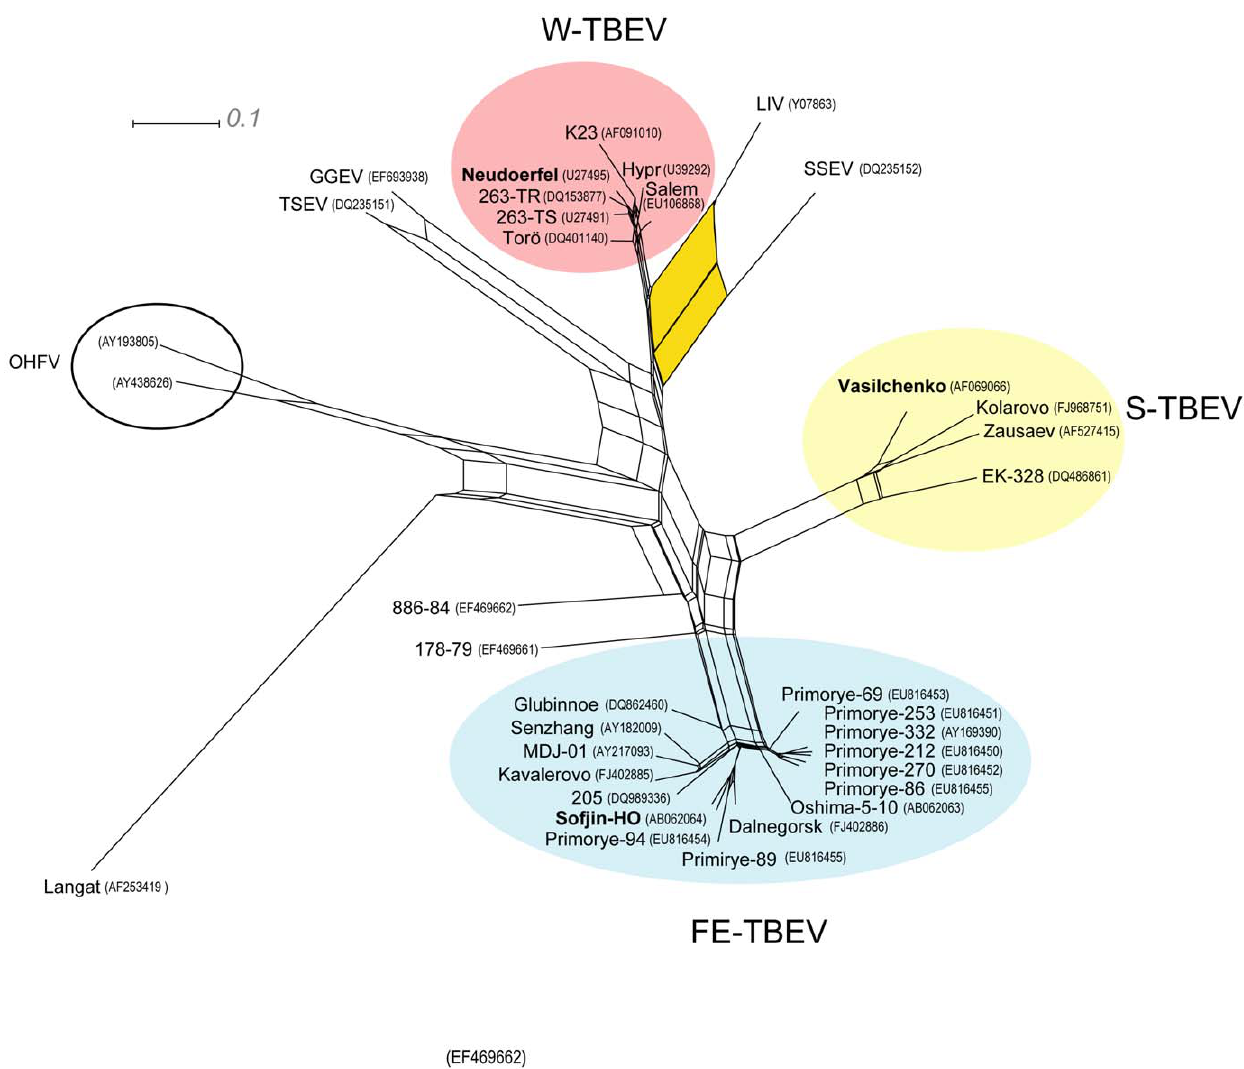
Figure 2. Split-graph constructed by the neighbor-net method based on 41 complete genomes of TBEV, LIV, LGTV and OHFV. The split-graph focuses on phylogenetic relationships within the Tick-borne encephalitis virus species. The three TBEV subtypes are highlighted in color and the positions of all prototype strains are indicated in bold. Two Russian strains (886–84 and 178–79) were not assigned to any main subtype at this stage. A larger split between LIV and SSEV (in yellow) suggests a recombination event.